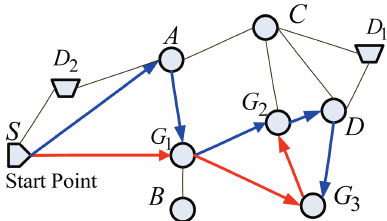
Fig. 2. Multiple goals visiting task.